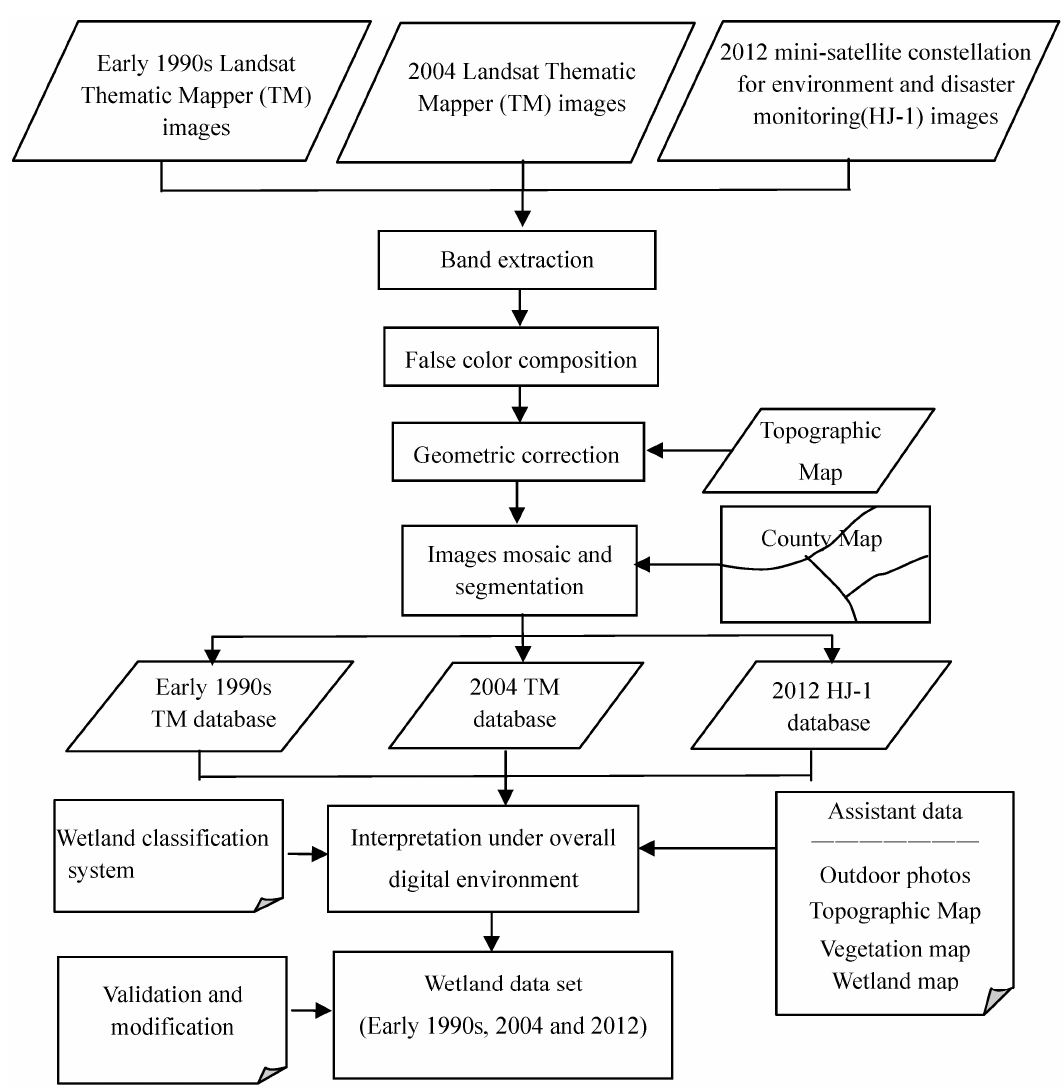
Figure 2. The technical process of wetland data interpretation by RS in the “Three-River Headwaters” (TRH)